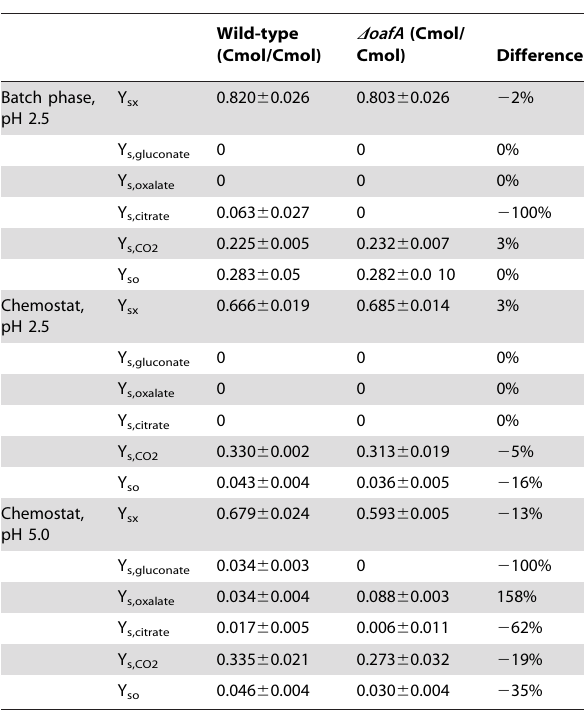
Table 3. Physiological coefficients from chemostat